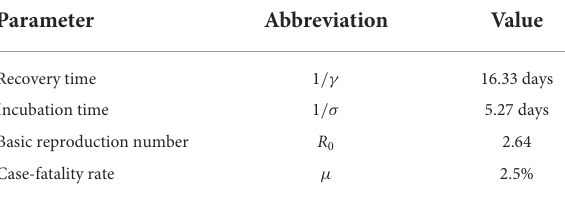
TABLE 1 Estimation results of COVID-19 virus parameters without any